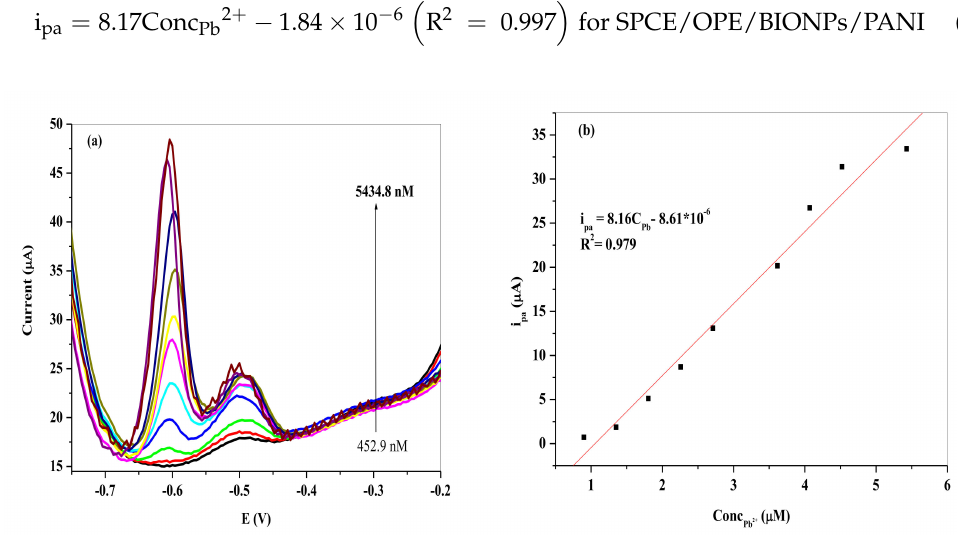
Figure 15. ( a ) SWVs of different concentrations of Pb 2+ on SPCE/LPE/BIONPs/PANI. ( b ) Calibration curves of the peak current vs. different concentrations of Pb 2+ . (Potential vs.